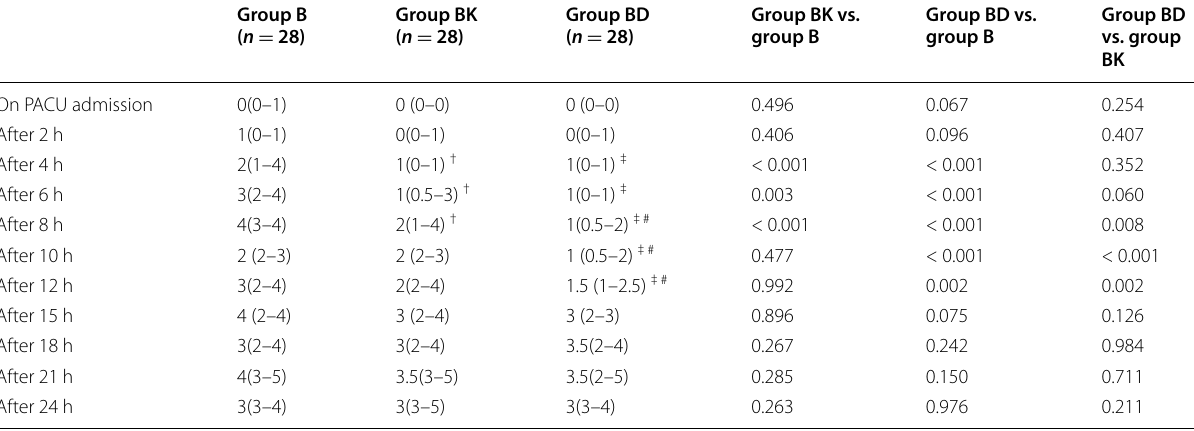
Table 6 Postoperative FLACC scores in study groups (data are expressed as median and interquartile range)